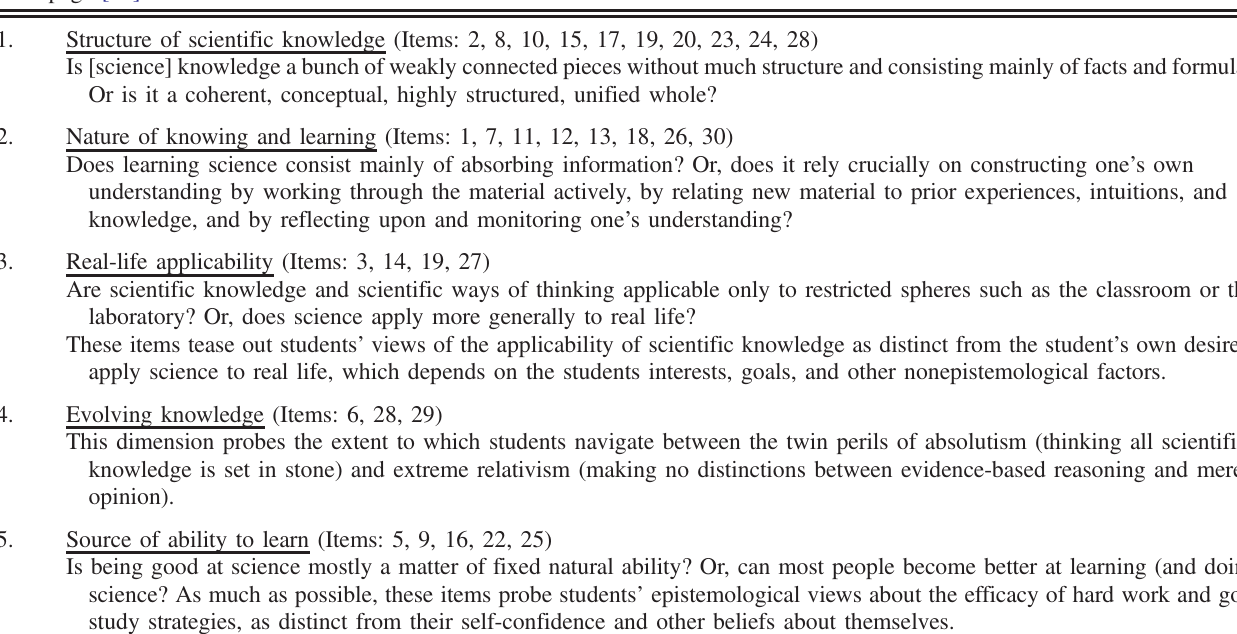
TABLE IX. Description of EBAPS axes and the items associated with these axes. These are the definitions as provided by the EBAPS homepage [12].